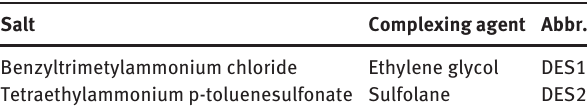
Table 1: DESs used in this